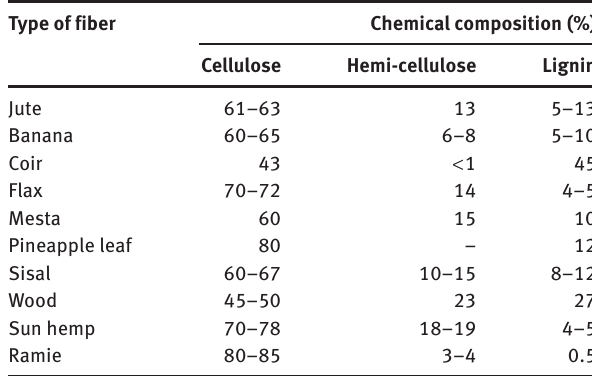
Table 1: Classification of natural fibers, origin, world annual production and cost [2].